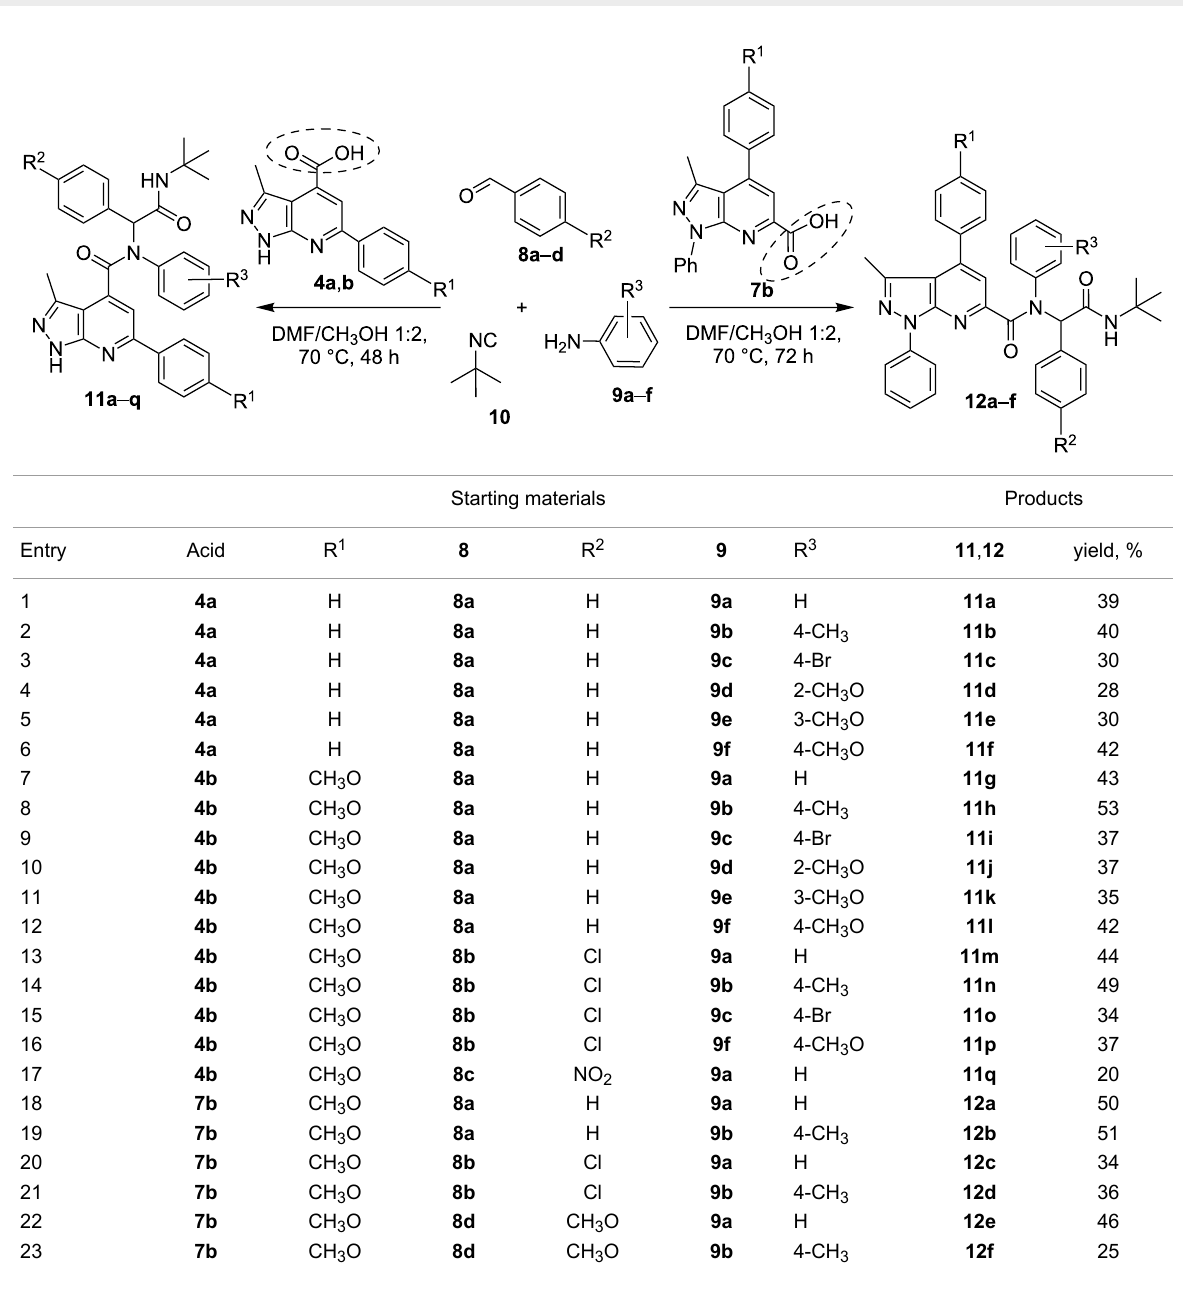
Table 1: Synthesis of compounds 11 and 12 by combination of Doebner and Ugi-type